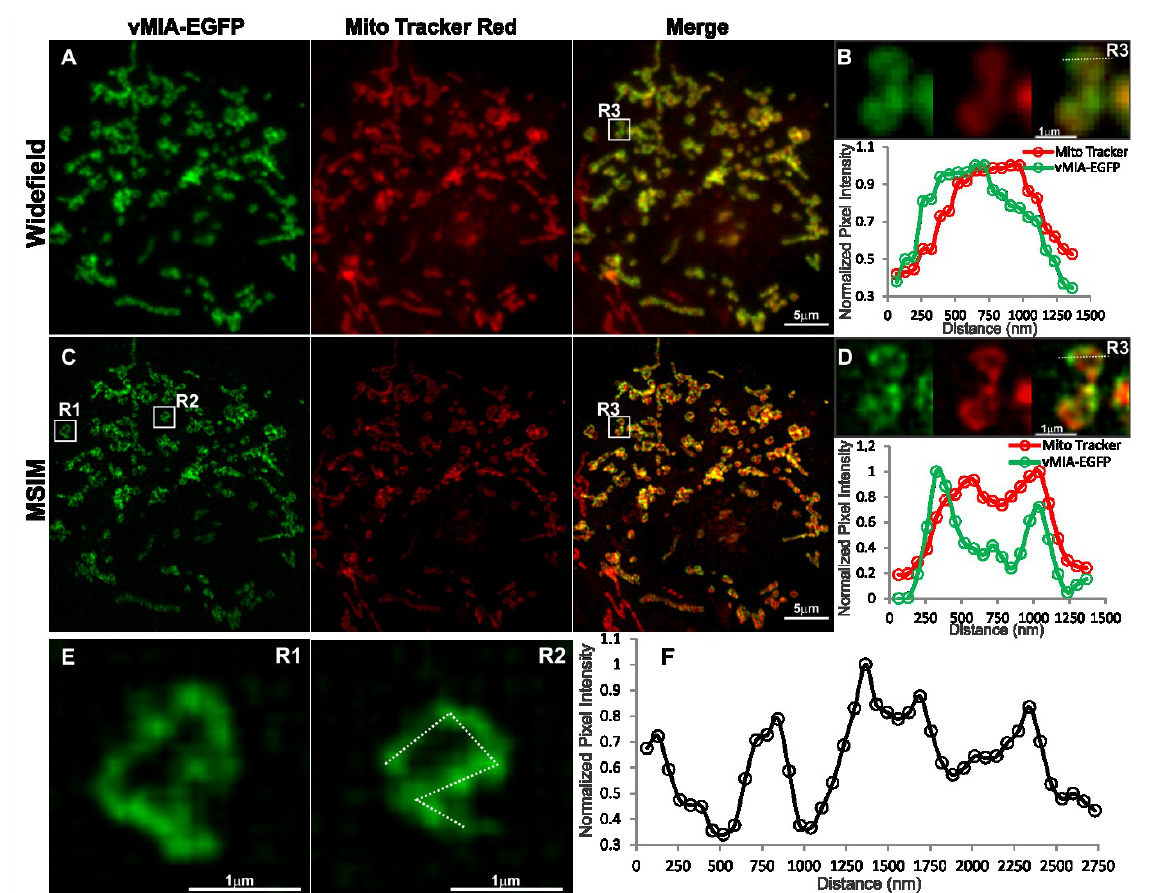
Figure 7. Imaging vMIA localization using widefield microscopy and MSIM. HFFs were transfected with vectors expressing TRE-tight promoter-vMIA-EGFP (green) and its tetracycline controlled transactivator (tTA) [53]. Transfected cells were Dox-treated (0.2 µg/mL) for one hour, MitoTracker Red treated (0.5 µM for 5 min, red) and methanol fixed as described [23]. 25 slices (0.2 µm step size) were collected using 488 nm and 561 nm excitation lasers. For each channel, 256 multifocal excited images were collected as the excitation array was stepped ~1 pixel in a 16 × 16 grid pattern. ( A ) Summation of the images produces the widefield fluorescence image, which shows high degree of co-localization between vMIA-EGFP and MitoTracker Red. ( B ) Zoomed images of mitochondria in the region marked R3 are shown and the plot below shows the intensity profile through the region marked by dotted line. ( C ) The MSIM image is shown. ( D ) The zoomed images of region R3 and the line scan for the region marked by dotted line show the improved ability to resolve the vMIA-EGFP and MitoTracker Red staining through the use of MSIM. ( E ) MSIM images of two mitochondria (R1 and R2) are shown. ( F ) Intensity profile through the perimeter of mitochondrion in R2 marked by dotted line is shown in the plot. This indicates non-uniform distribution of vMIA-GFP along the mitochondrial membrane. For higher resolution images, see Supplemental Figure